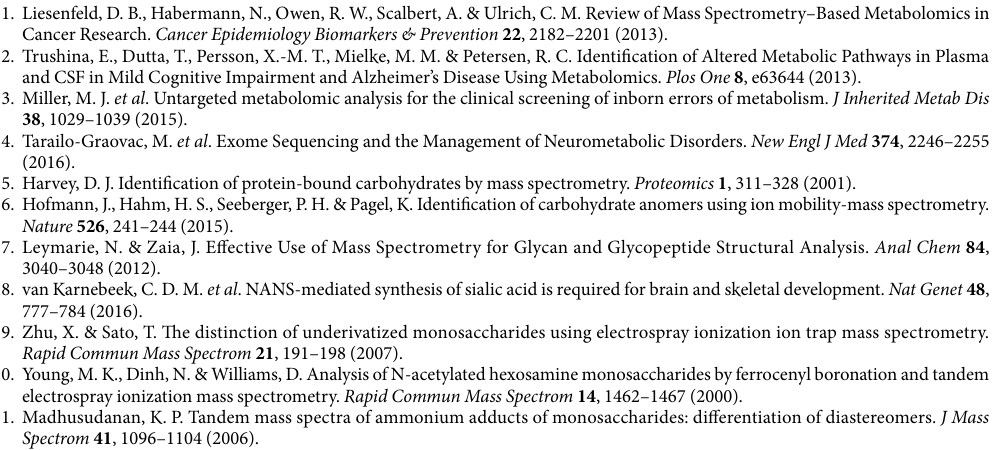
Methods Infrared Ion spectroscopy.